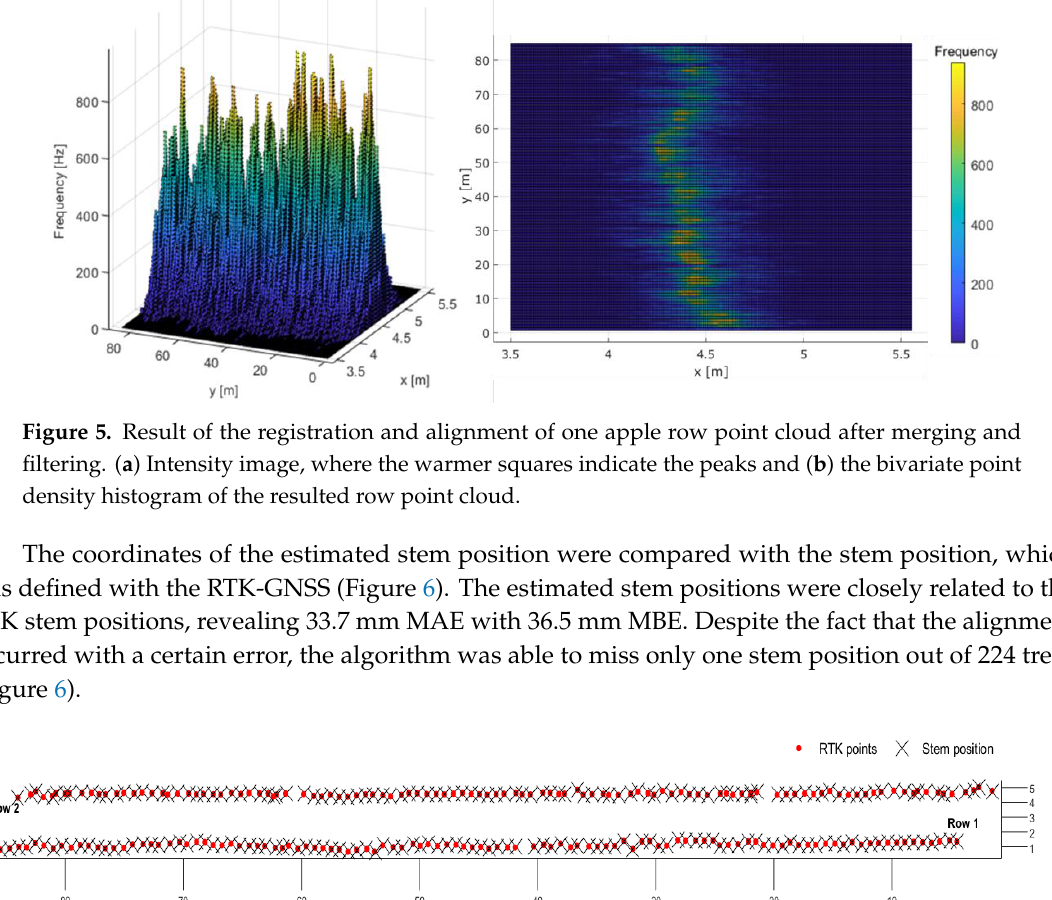
Figure 4. Registration and alignment using the iterative closest point algorithm (ICP) algorithm of a single tree point cloud in two cases ( a ) tree point cloud with soil points ( b ) tree point cloud after soil removal with RANSAC. The trees with the best results for each case are presented.